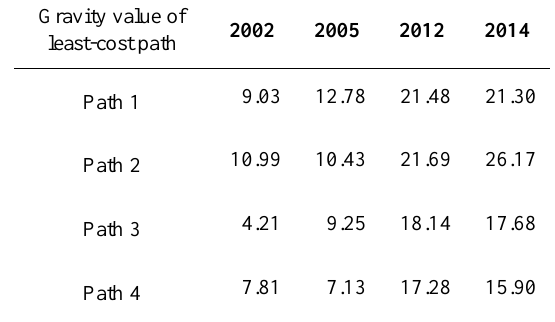
Table 6. Gravity value of least-cost path from 2002-2014.